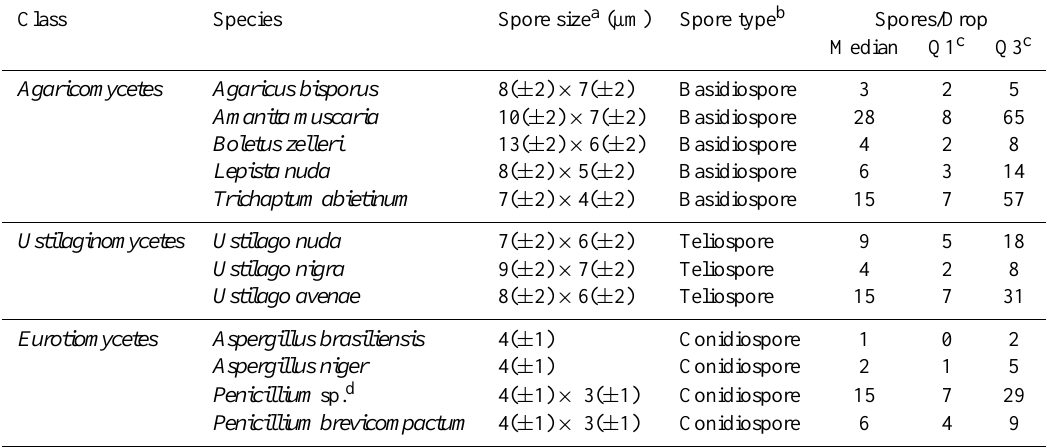
Table 1. Description of the fungal spores investigated in the current study. Class